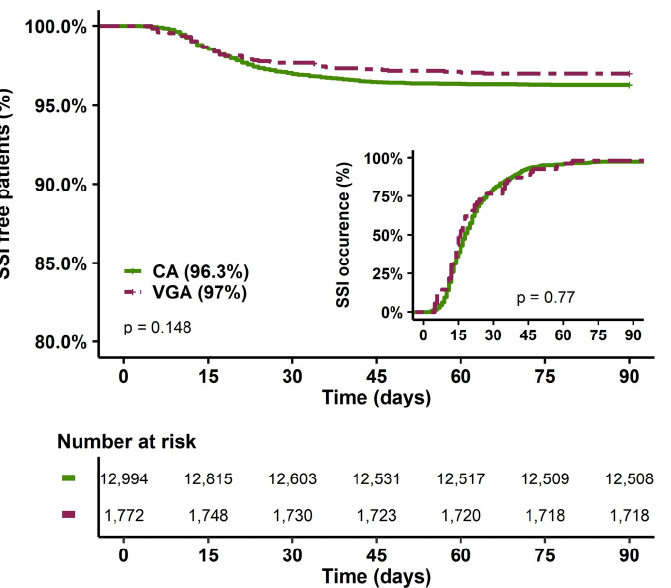
Figure 2. SSI-free patients at 90 days and delay of SSI occurrence according to the type of prophylaxis. CA, cephalosporin antibiotic prophylaxis; VGA, vancomycin/gentamicin antibiotic prophylaxis; SSI, surgical site infection. Table 2. Multivariate analysis of risk factors for SSI.